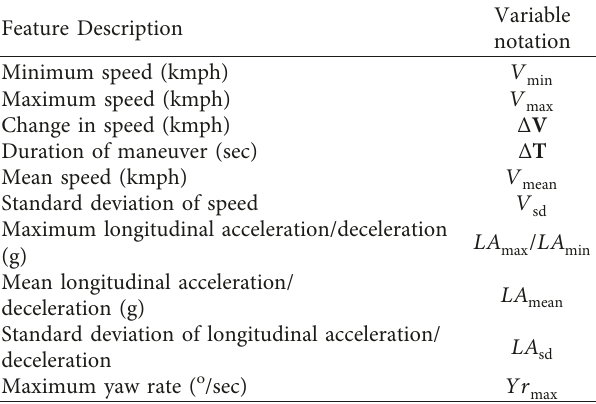
Table 2: Driving performance features of acceleration and braking